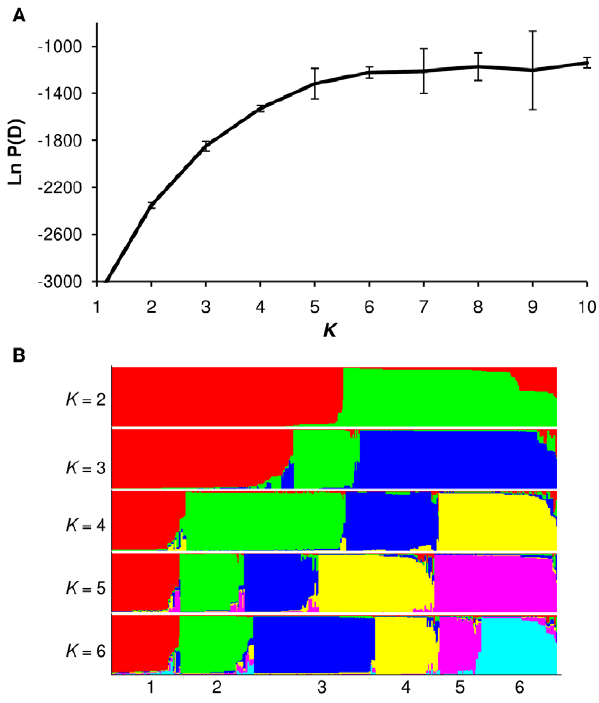
Figure 3. Population structure of the gene encoding DBP II based on Bayesian cluster analysis using Structure 2.3 software. (A) Plot of the log probability of the data [Ln P (D)] and its standard deviation (vertical bars) given values for K of 1–10. (B) Population clustering for K =2–6. Each individual is represented by a thin vertical color. Each color represents an ancestral population (pop), and the color of individual represents their proportional membership in the different populations. Ancestral populations: red, pop1; green, pop2; blue, pop3; yellow, pop4; pink, pop5 and light blue, pop6. The figure shown for a given K is based on the highest probability run at that K . doi:10.1371/journal.pone.0022944.g003 plotted the average Q for each country. For all countries but South Korea the analysis supported low levels of differentiation among geographical regions, with three to six ancestral populations present in each country (Figure 4).